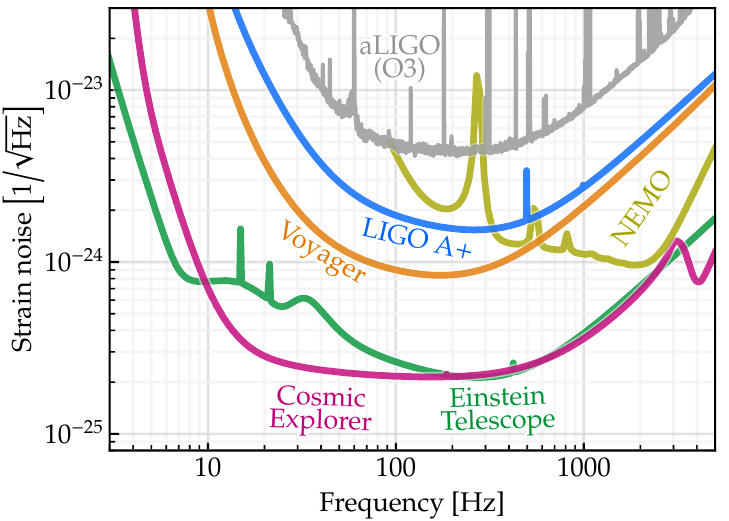
Figure 3. Strain curves for selected current and next-generation detectors, including a 40km Cosmic Explorer. The curves indicate the sensitivity for an optimally oriented and polarized monochromatic source. Several subtleties of these curves for the next-generation detectors are discussed in Section